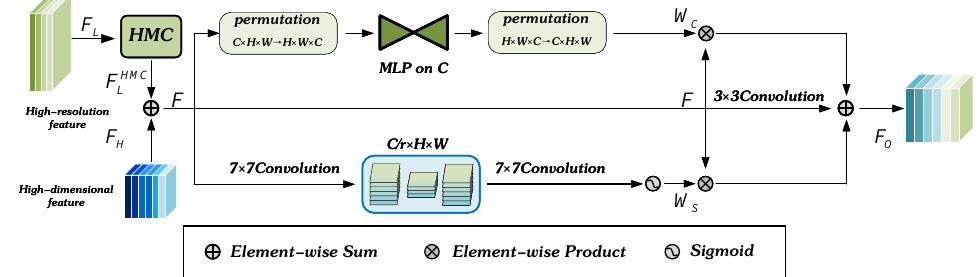
Figure 4. The structure of MGA. HMC represents the Hierarchical Multi-scale Convolution module. MLP represents Multi-layer perceptron neural